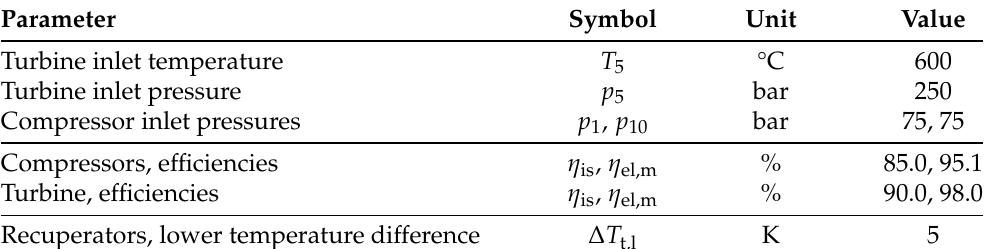
Table 5. sCO 2 power cycle—Parameters of the overall process and components [75]. Parameter